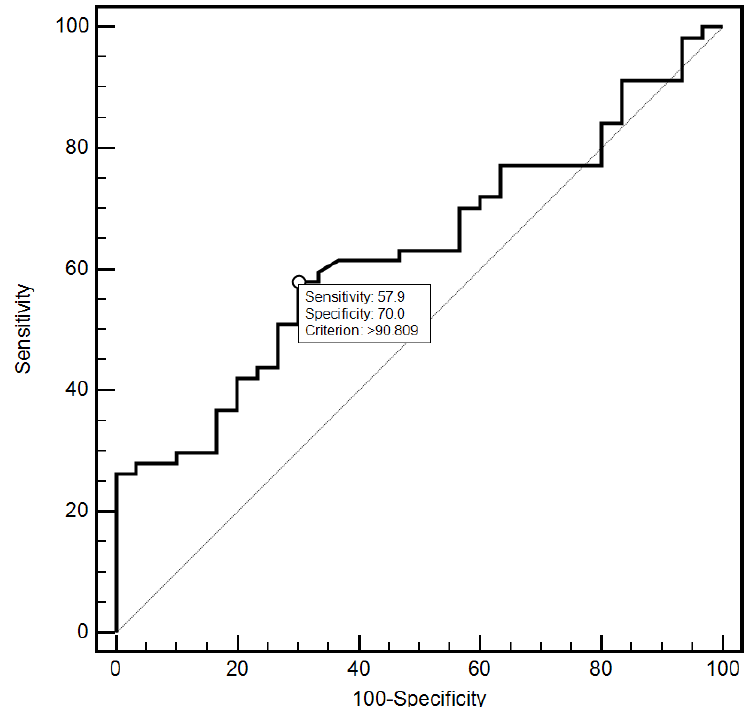
11 Figure 11. Evaluation of the diagnostic usefulness of MMP-8 (ng/mL) concentration determination in samples taken from the cervix in early detection of preterm labor using the ROC curve.